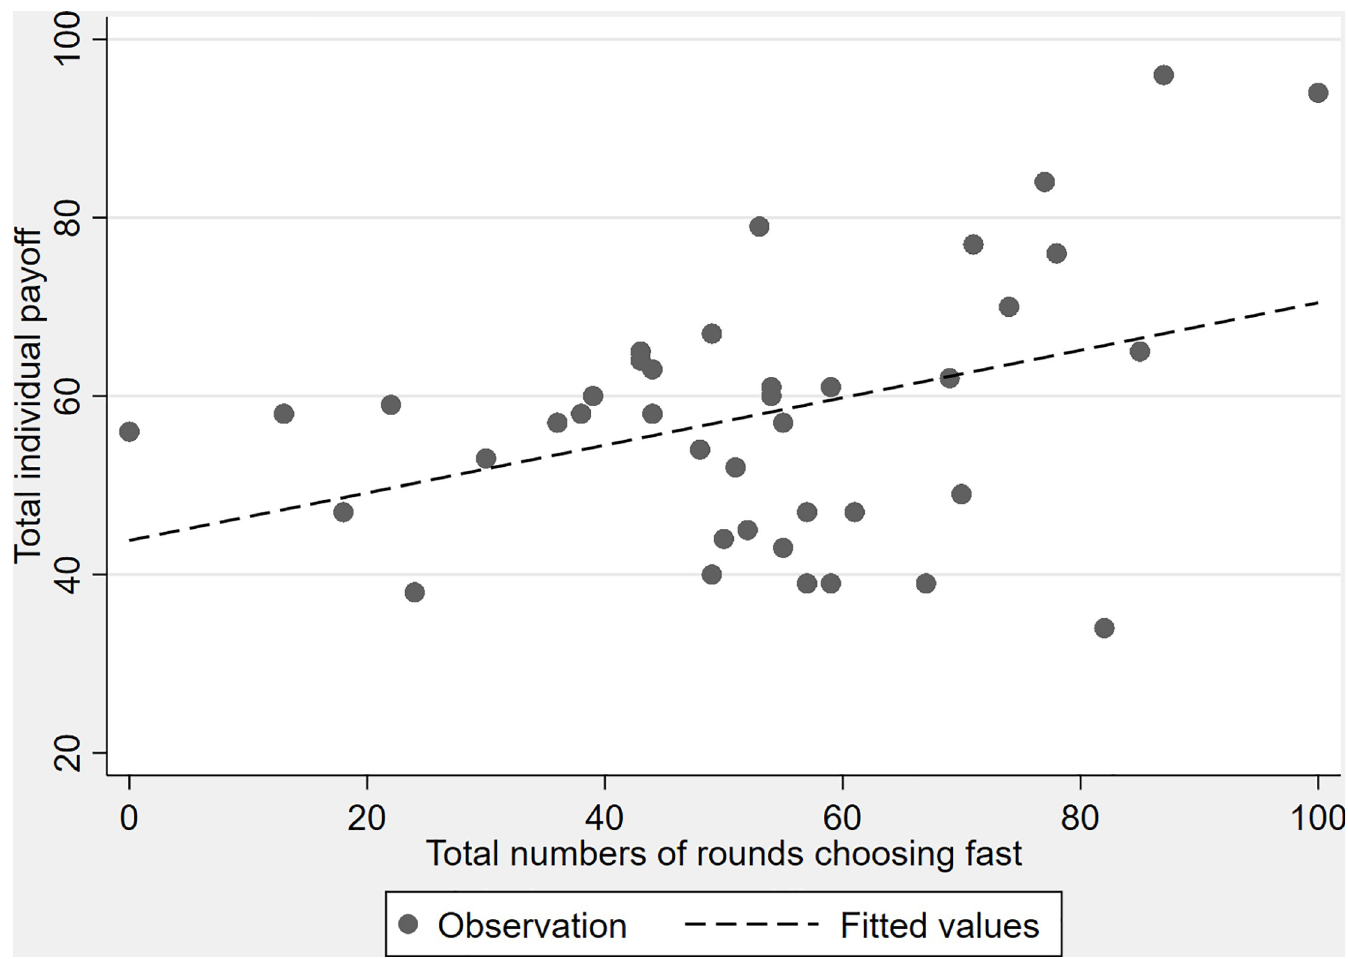
Fig 3. Total payoff depending on the total number of rounds choosing